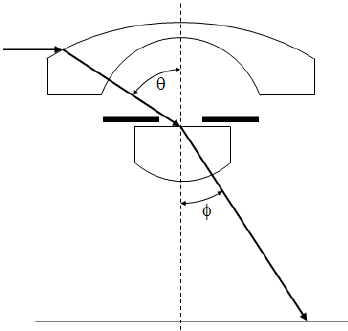
Figure 2. Example of difference in incident (𝜃) and resulting (𝜙) ray in fisheye lens